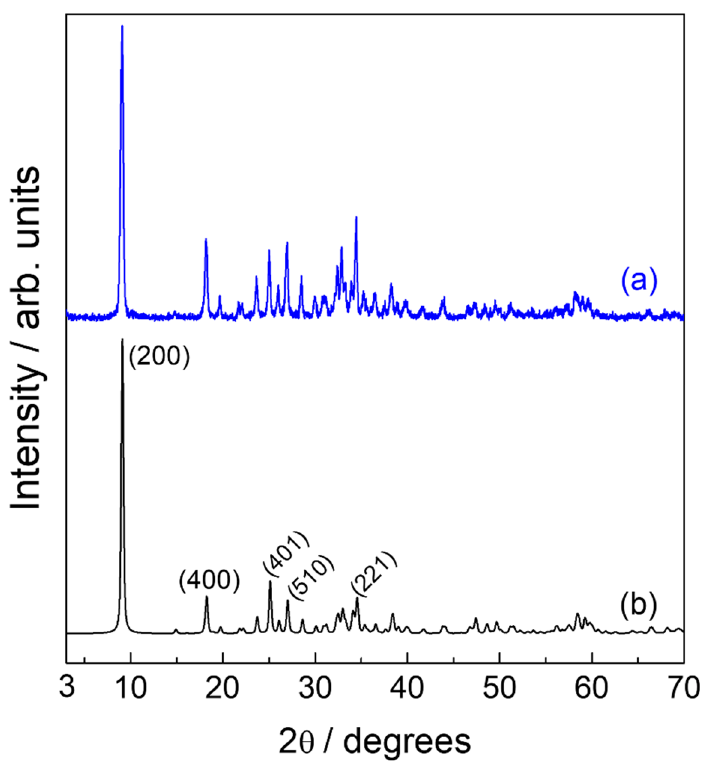
Figure A1. XRD pattern of the ( a ) Zn-NO 3 -LSH host matrix and ( b ) JCPDS-PDF n° 72-627 card.